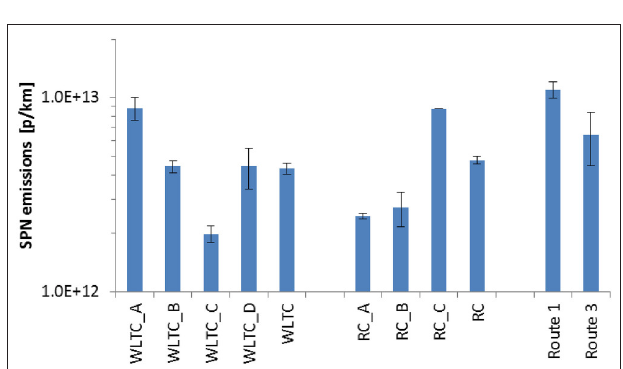
FIGURE 8 | SPN emissions of Vehicle GDI #6 over various phases of the WLTC and the random driving cycle as well as two on-road